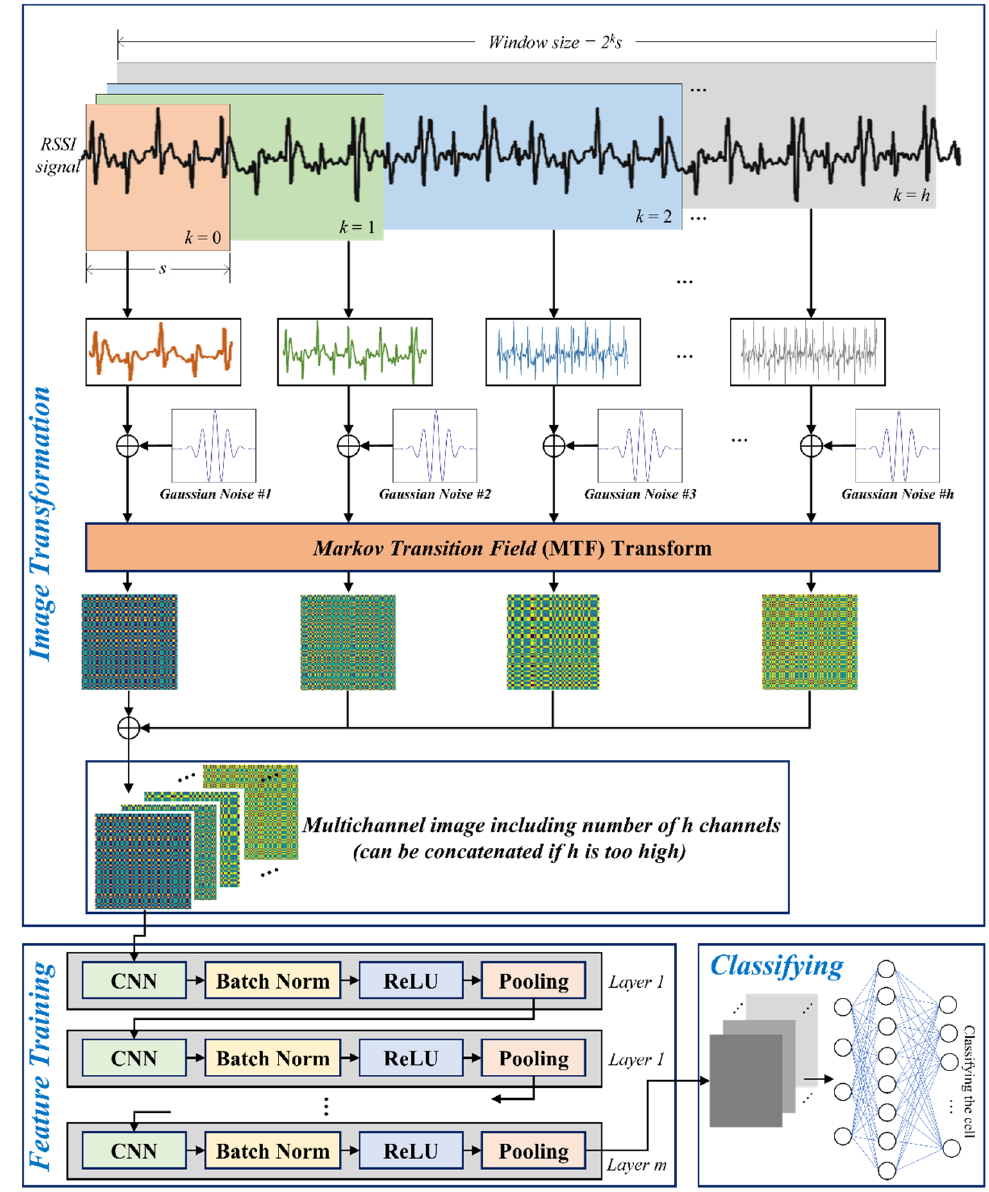
Figure 6. Process of training an image to decide indoor position through artificial Gaussian noise injection and MTF-based image transformation by concatenating multiple sliding windows.